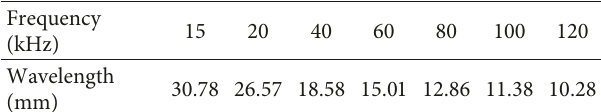
Figure 8: Theoretical and experimental directivity of the piezoelectric fiber: (a) theoretical directivity; (b) directivity at 20kHz; (c) experimental directivity. Table 1: Wavelength of the flexural Lamb wave at different